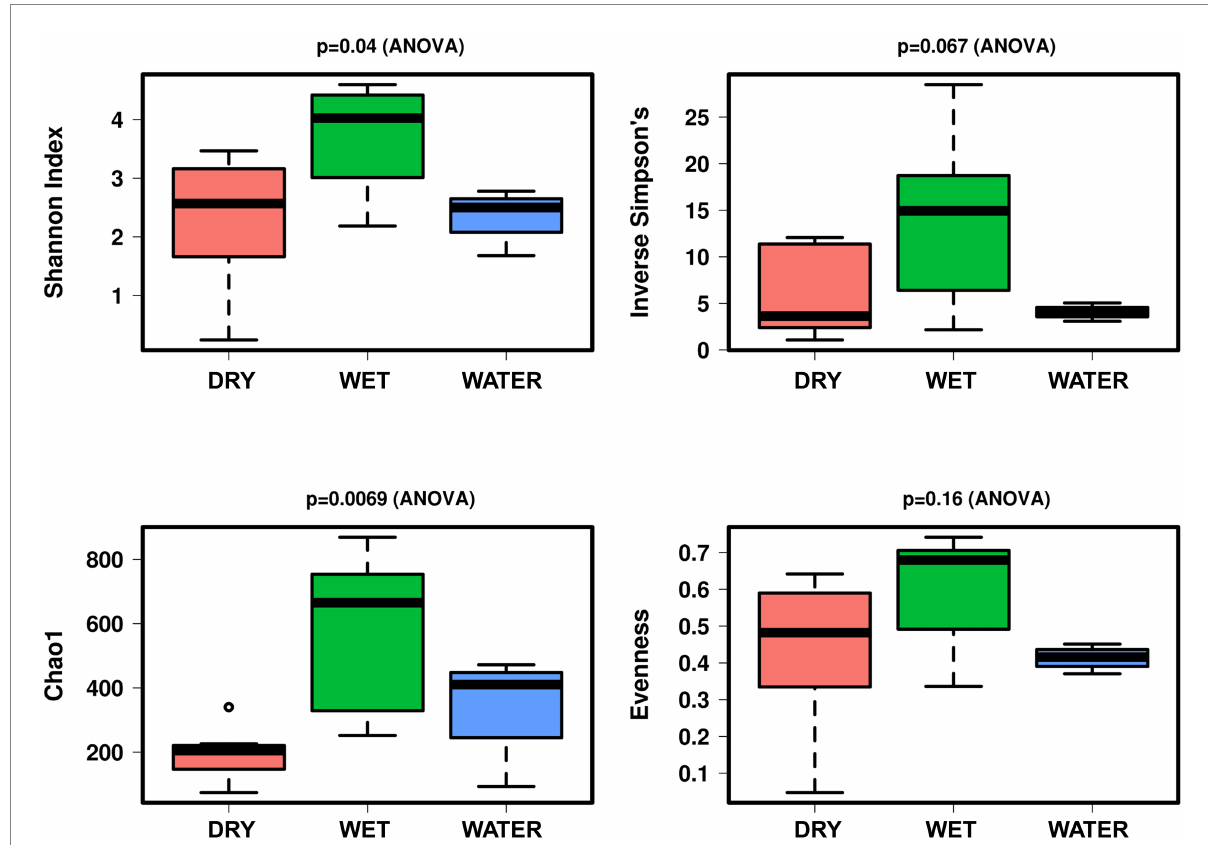
FIGURE 3 Boxplot of alpha diversity indices (Shannon, Simpson, Evenness, and Chao1) of the Imawarì Yeuta samples grouped based on water content. The p -value indicating the statistical significance of the analysis (calculated by one-way ANOVA) is indicated above each